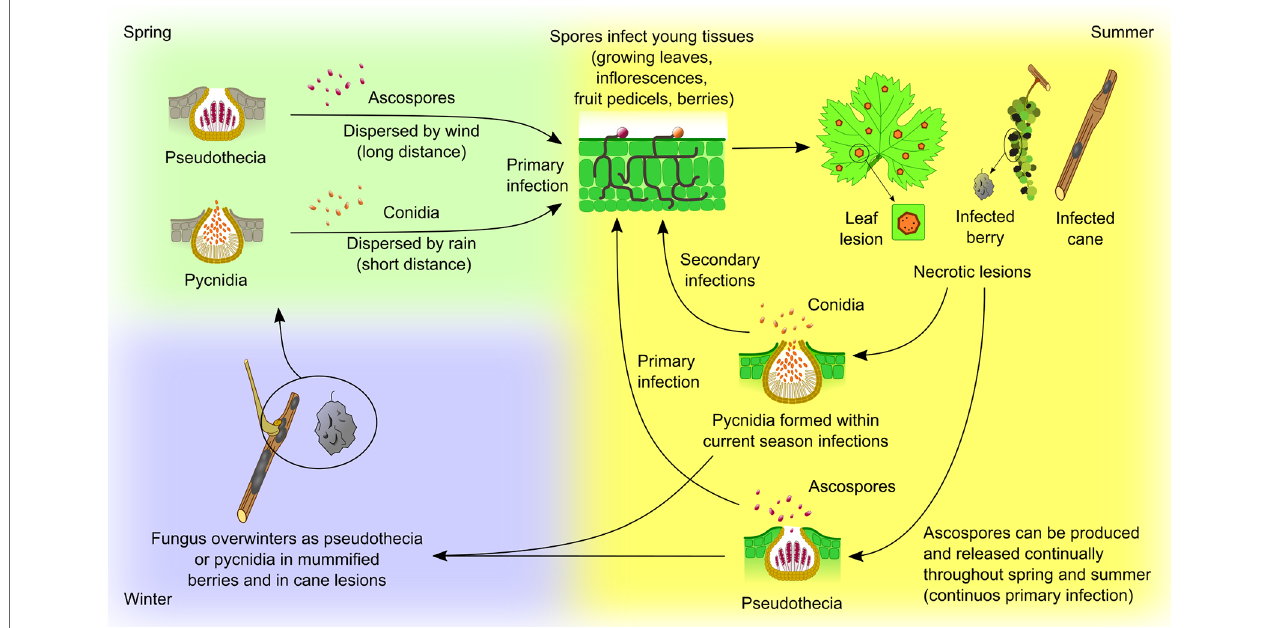
FIGURE 4 | Guignardia bidwellii life cycle. The fungus overwinters in mummified berries, retained on the vine or fallen to the ground, and on infected canes. Berry mummies host both pseudothecia, containing asci with ascospores, and pycnidia, with conidia, while canes and tendrils host pycnidia. Lesions capable of producing conidia can persist in the wood for at least two years. In spring, ascospores and conidia are released when pseudothecia and pycnidia become thoroughly wet; infection is therefore favored by frequent rainfall as the spores need water to be released and to germinate. Ascospores released from mummified berries are the most common form of primary inoculum. They are ejected actively from the asci during rainfall and are dispersed by wind currents (long distance dispersion). On the contrary, conidia are exuded from the pycnidium in a white, mucilaginous cirrus from which they can be splashed away by rain (short distance dispersion). Primary infection from ascospores or conidia takes place on young, rapidly growing green tissues (growing leaves, inflorescences, fruit pedicels, berries). Adult leaves and ripe fruits, that have become fully expanded, are not susceptible to infection. Pycnidia are produced rapidly within the necrotic lesions found on leaves, shoots and berries, and, once mature and dampened by rain, they release the conidia which serve as secondary inoculum throughout the season. When the weather is moist, ascospores may be produced and released continually throughout spring and summer from mummies retained in the canopy, providing continuous primary infection, although most of them are discharged in the spring. In late summer, the sexual cycle initiates on infected berries and pseudothecia are formed (Wilcox et al., 2017).